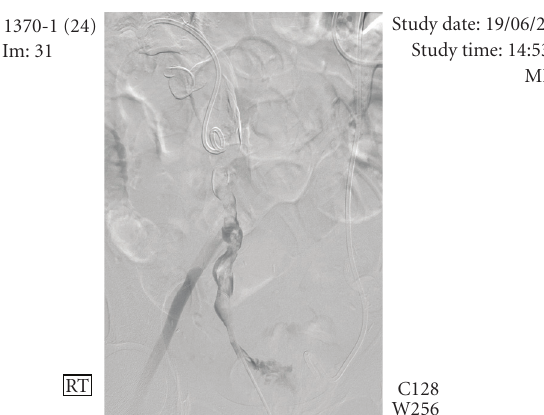
Figure 1: Uretero-external iliac artery fistula demonstrated on angiographic run.